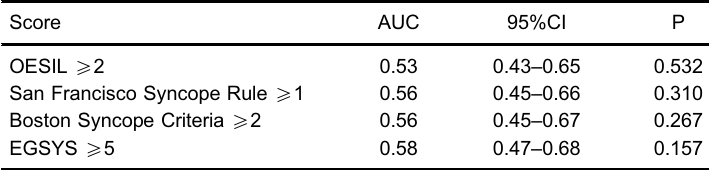
Table 2. Predictive ability of the